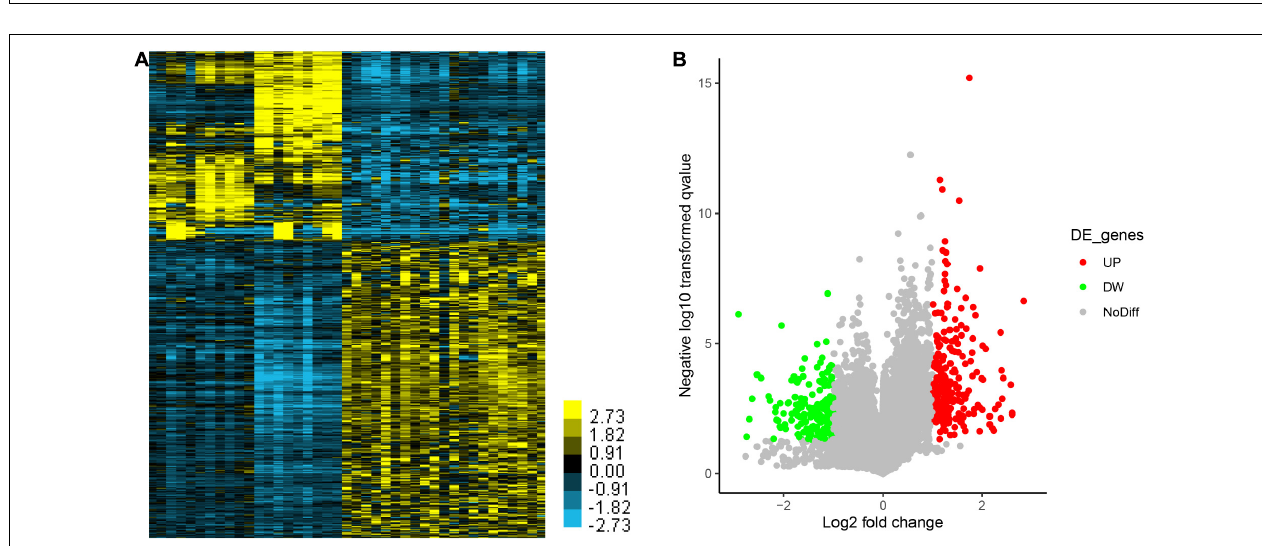
FIGURE 2 | Bioinformatics analyses of common differentially expressed genes (DEGs) in esophageal adenocarcinoma (EA) and esophageal squamous cell carcinoma (ESCC). (A,B) Gene Ontology (GO) functions and Kyoto Encyclopedia of Genes and Genomes (KEGG) analysis of the common upregulated genes in esophageal cancer (EC). (C,D) GO functions and KEGG analysis of the common downregulated genes in esophageal cancer (EC).